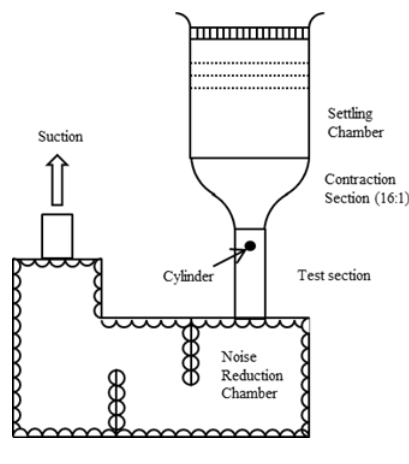
Fig.1 Schematics of the experimental